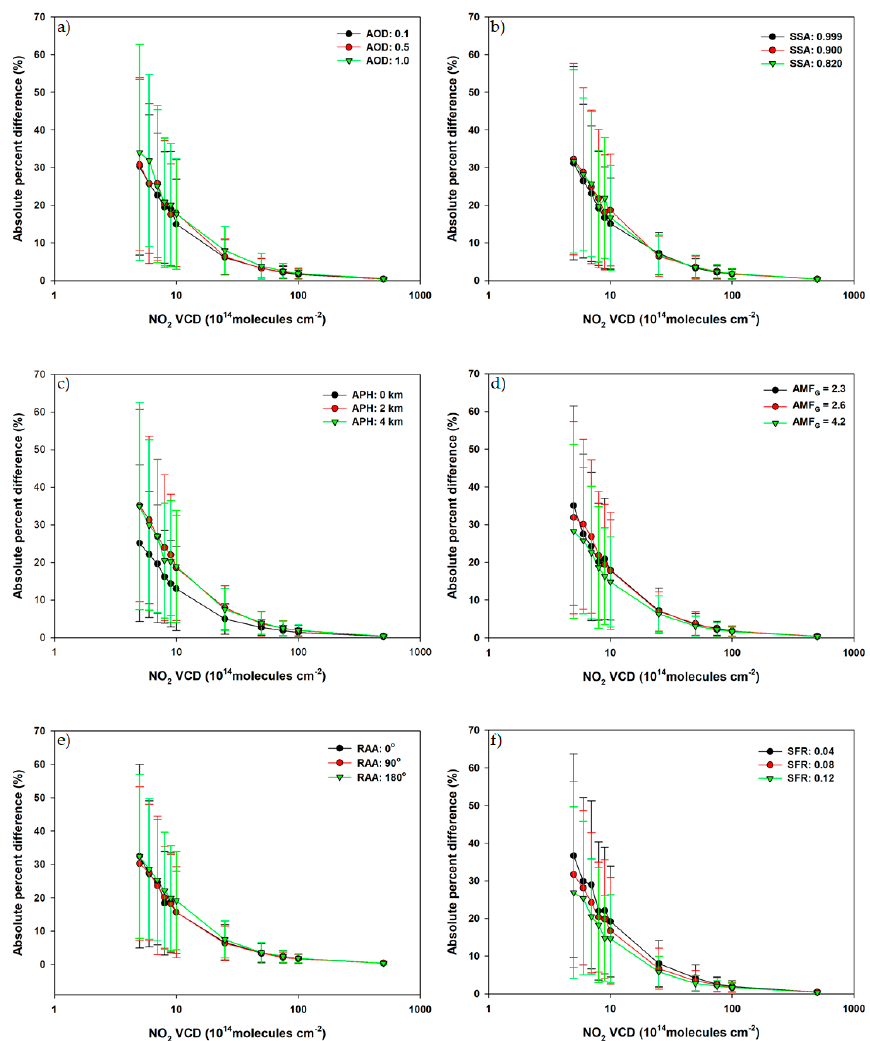
Figure 6. Absolute percentage difference (APD) between true and retrieved NO 2 SCDs using a spectrum with noise (SNR = 2000) as a function of NO 2 VCD with ( a ) AOD of 0.1, 0.5, and 1.0; ( b ) SSA of 0.999, 0.900, and 0.820; ( c ) APH of 0, 2, and 4 km; ( d ) AMF G of 2.3, 2.6, and 4.2; ( e ) RAA of 0°, 90°, and 180°; and ( f ) SFR of 0.04, 0.08, and 0.12. (Slant column density (SCD), signal-to-noise ratio (SNR), vertical column density (VCD), aerosol optical depth (AOD), single scattering albedo (SSA), aerosol peak height (APH), air mass factor (AMF), relative azimuth angle (RAA), and surface reflectance (SFR)).